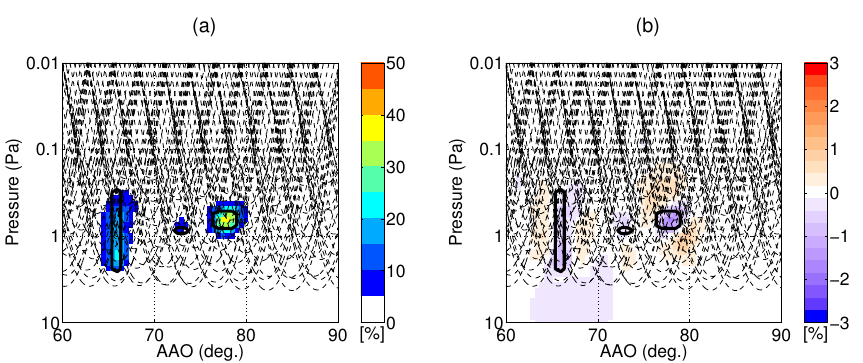
Figure 4. Water vapour (a) and temperature (b) from the tomographic retrievals where a 50% enhancement of water vapour is simulated in the areas marked by the black squares. The results are presented in terms of deviation from the a priori (% and K). The dashed lines show the lines-of-sight of